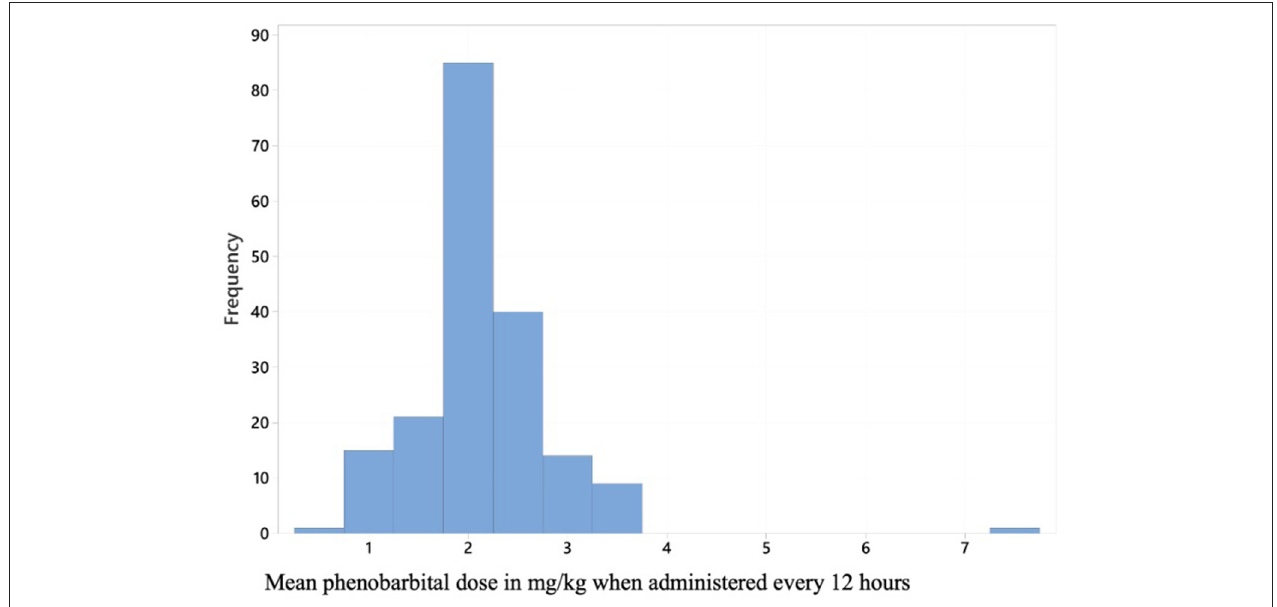
FIGURE 2 | A histogram displaying initial phenobarbital dose reported by the 206 respondents who selected phenobarbital as their preferred first line antiseizure drug for canine idiopathic epilepsy.